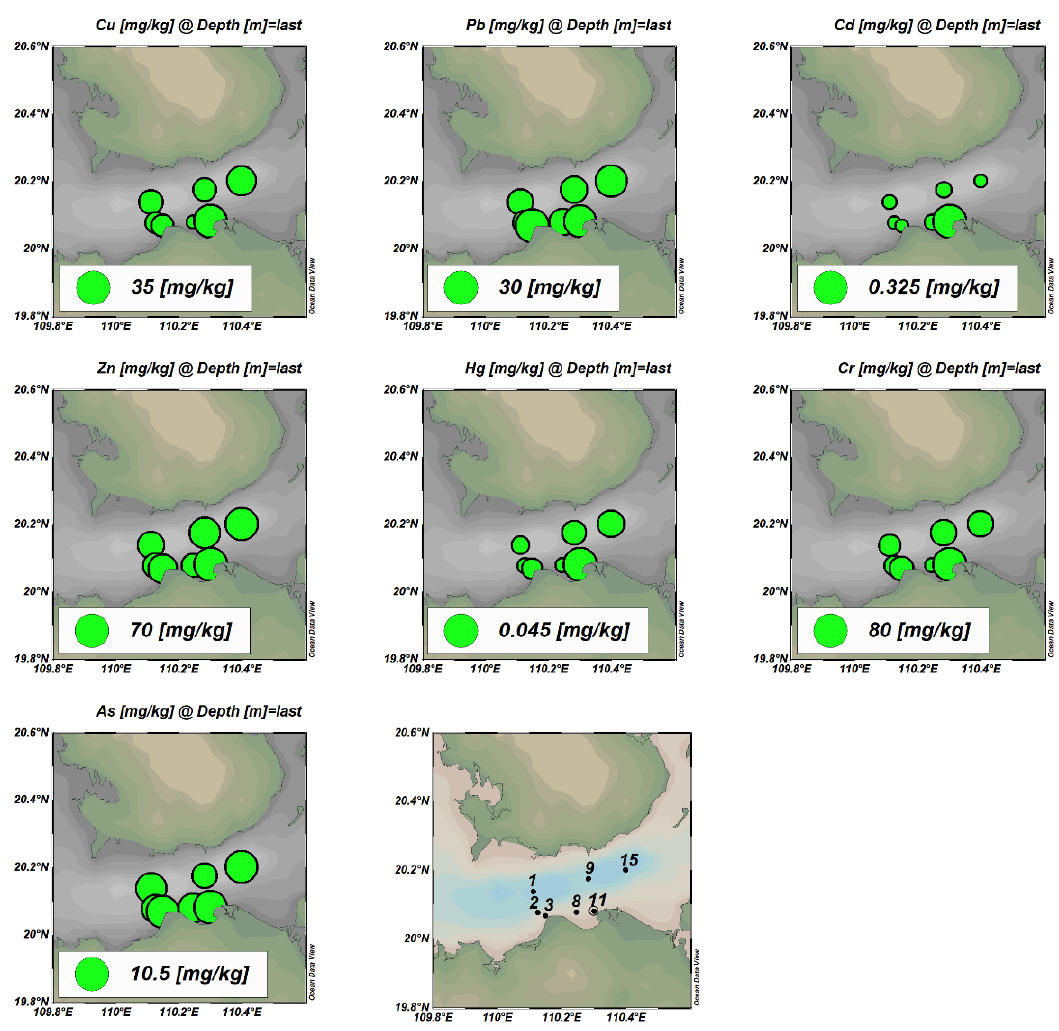
Figure 3. Spatial distribution of seven heavy metals in surface sediments.